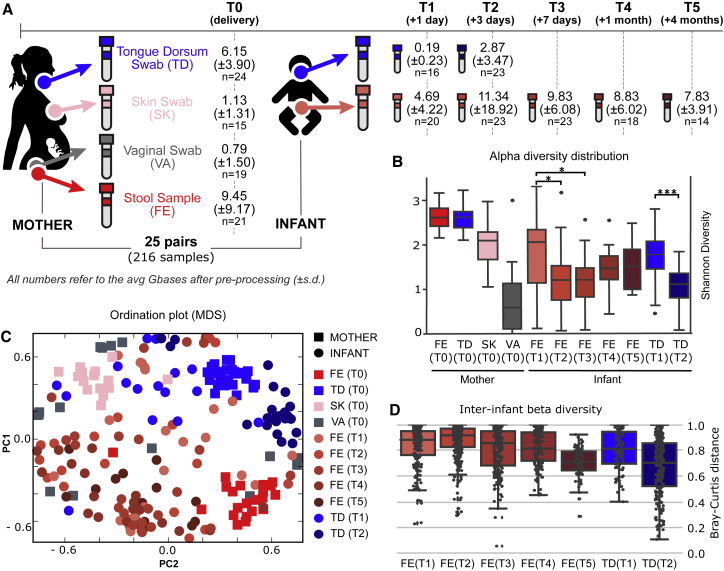
Longitudinal Metagenomic Sequencing of the Microbiome of Mother-Infant Pairs(A) Samples were collected from 25 mother-infant pairs and metagenomically sequenced. Samples were taken from the stool (FE), skin (SK), vagina (VA), and tongue dorsum (TD) of the mothers and from the stool and tongue dorsum of the infants. Sampling of the infant started within 24 hr from delivery and continued for up to 4 months (STAR Methods). All samples were shotgun sequenced and the average depth (in Gbases) of the quality-controlled and human DNA-free samples are reported.(B) Alpha-diversity distributions for each sample type and time point (∗p < 0.05, ∗∗∗p < 0.001).(C) Ordination plot (MDS) of all the samples that passed preprocessing based on the Bray-Curtis distance between samples highlights the spatial clustering of samples with respect to both different body sites and longitudinal time points.(D) Beta diversities (Bray-Curtis on log-scaled relative abundances) between samples within each infant body site (gut and tongue dorsum) across time points.